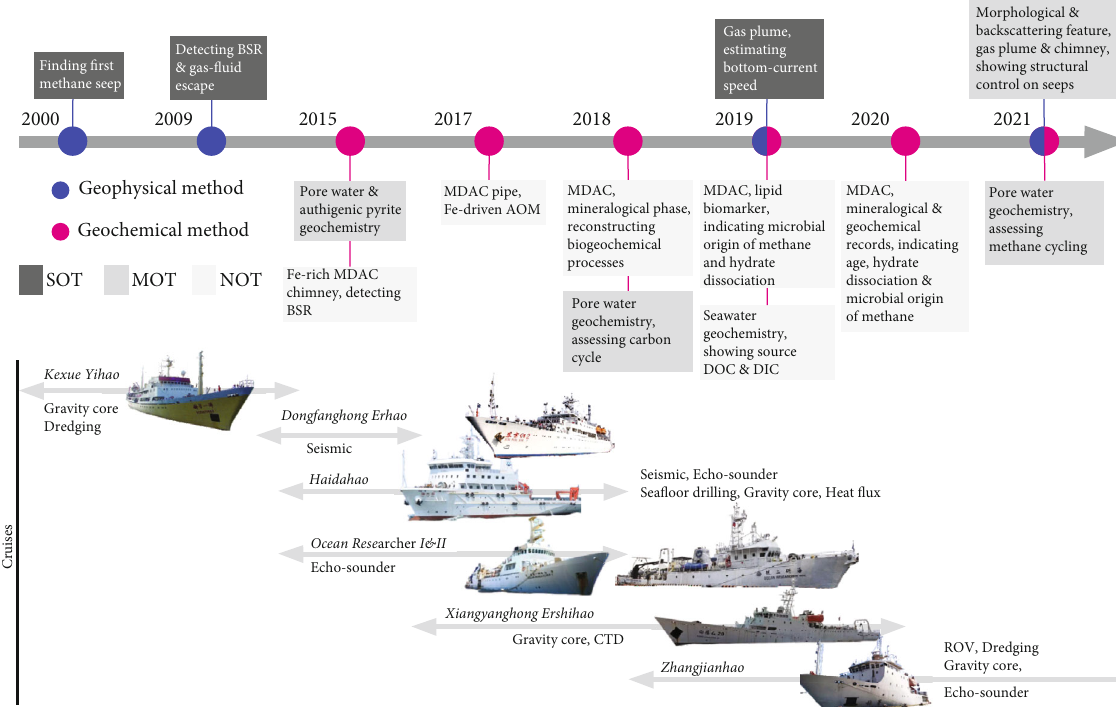
Figure 1: Timeline of the key researches and the cruises in the Okinawa Trough. SOT: southern Okinawa Trough; MOT: middle Okinawa Trough; NOT: northern Okinawa Trough in this and the subsequent fi gures and tables; MDAC: methane-derived authigenic carbonate; AOM: anaerobic oxidation of methane; DOC: dissolved organic carbon; DIC: dissolved inorganic carbon; BSR: bottom simulating re fl ector.